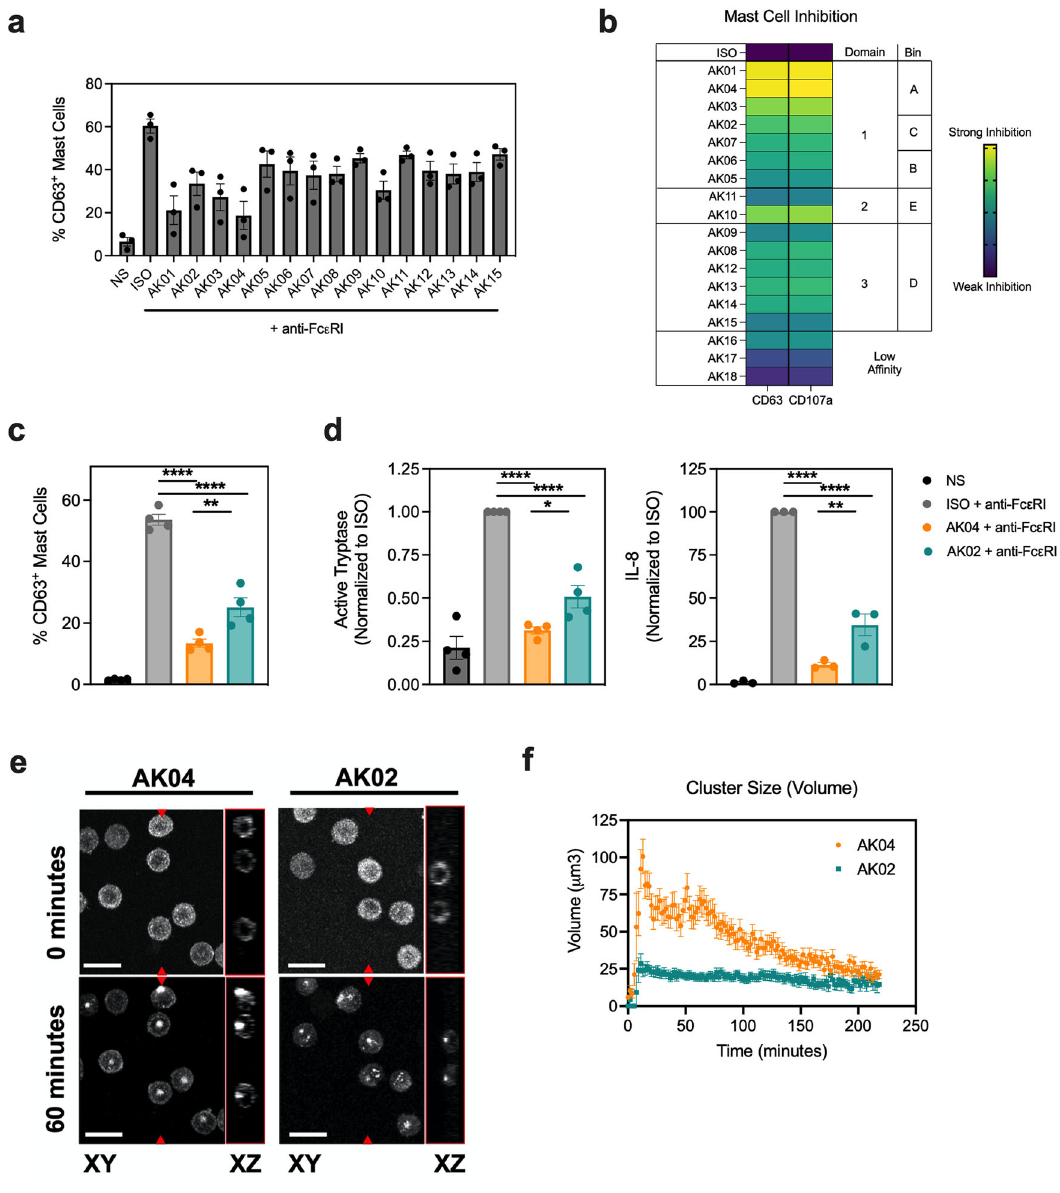
inhibition induced by Siglec-6 mAb clones (5 μ g mL − 1 ) and their respective binding domains and bins. c Percentage of CD63 + hMCs activated with anti- Fc ε RI antibody (CRA-1, 250 ng mL − 1 ) in the presence of 5 μ g mL − 1 AK04 (orange), AK02 (green) or an isotype control (gray) compared to unstimulated hMCs (black). d Normalized supernatant levels of active tryptase and IL-8 from anti-Fc ε RI activated hMCs incubated with AK04 (orange), AK02 (green), or isotype control (gray). e Representative live confocal images of hMCs incubated with 5 μ g mL − 1 AK04 or AK02 at 0 and 60 min. Scale bar = 15 μ m. f Quanti fi cation of Siglec-6 cell surface clusters induced by AK04 (orange) and AK02 (green) over 250min. Data are plotted as mean ± SD (three independent donors) and are representative of at least 2 experiments. * P < 0.05; ** P < 0.01; *** P < 0.001; **** P < 0.0001 by two-way ANOVA with Š idák multiple-comparisons